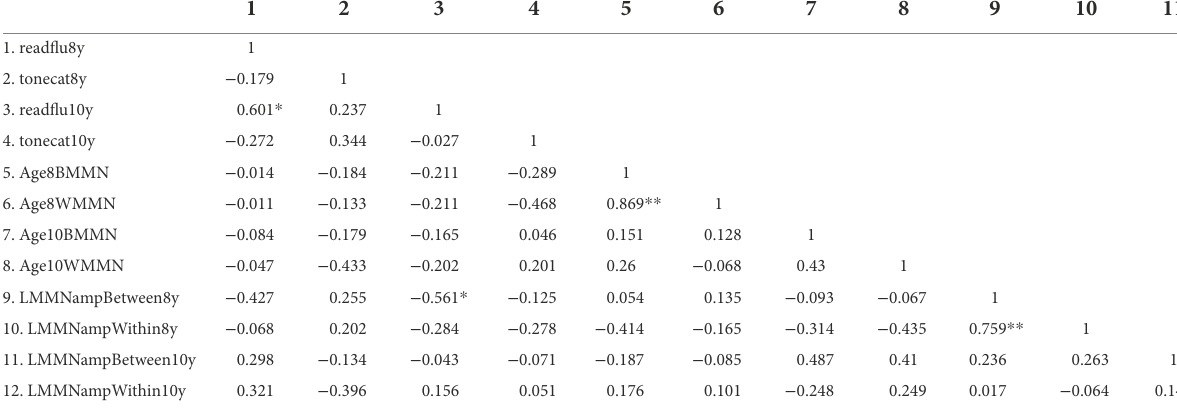
TABLE 1 Correlation coefficients between EEG and cognitive skills.